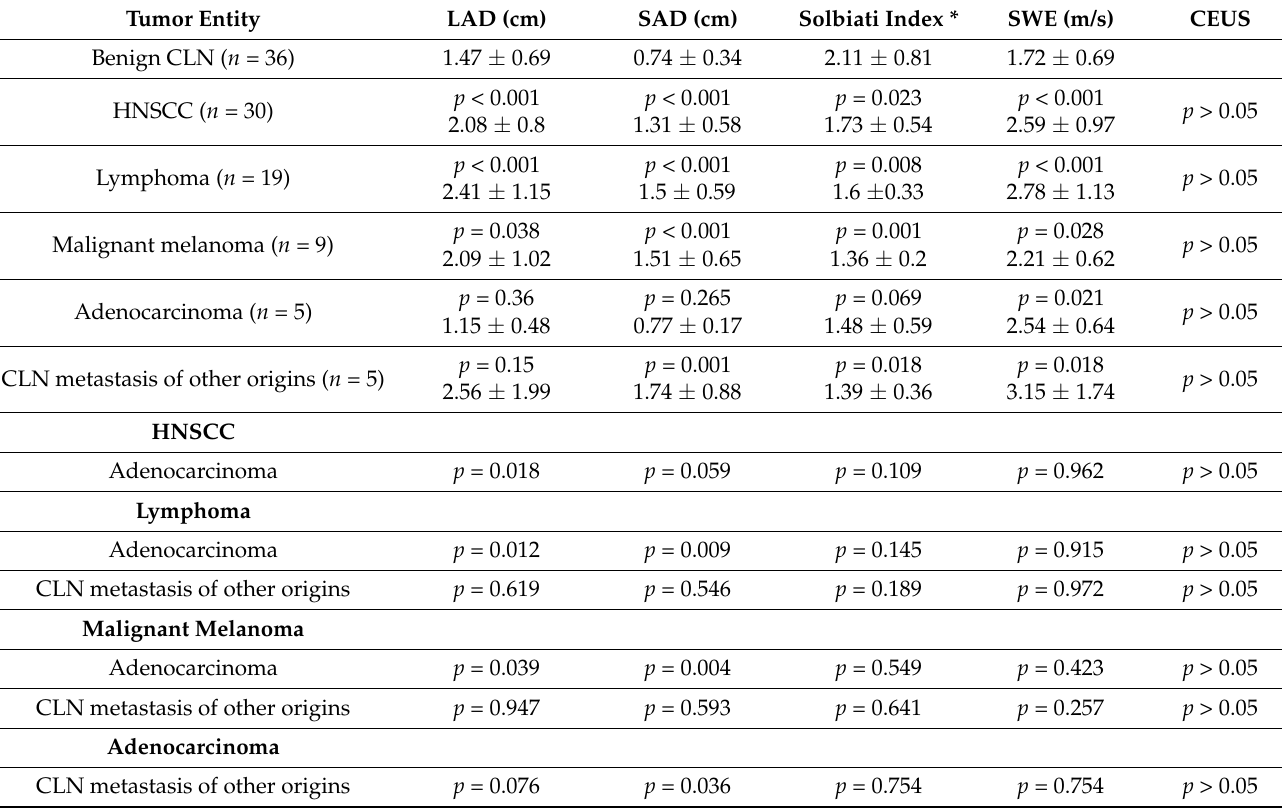
Table 5. All metric variables are given as median with corresponding standard deviation. Only values with a p value < 0.05 are shown. The group that is compared to the subgroups is printed in bold letters. Abbreviations: SWE, shear wave elastography; HNSCC, head and neck squamous cell carcinoma; CLN, cervical lymph node; CEUS, contrast enhanced ultrasound; LAD, long-axis diameter; SAD, short-axis diameter; n , number of lymph nodes